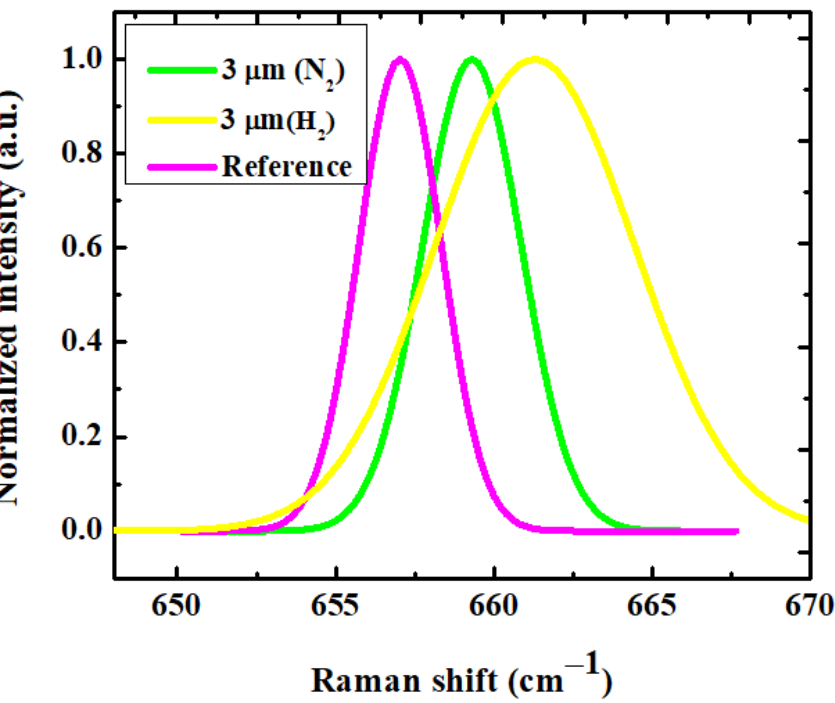
Figure 8. Normalized Raman data of AlN samples grown in N 2 , H 2 carrier gases, and free-standing AlN grown by HVPE.